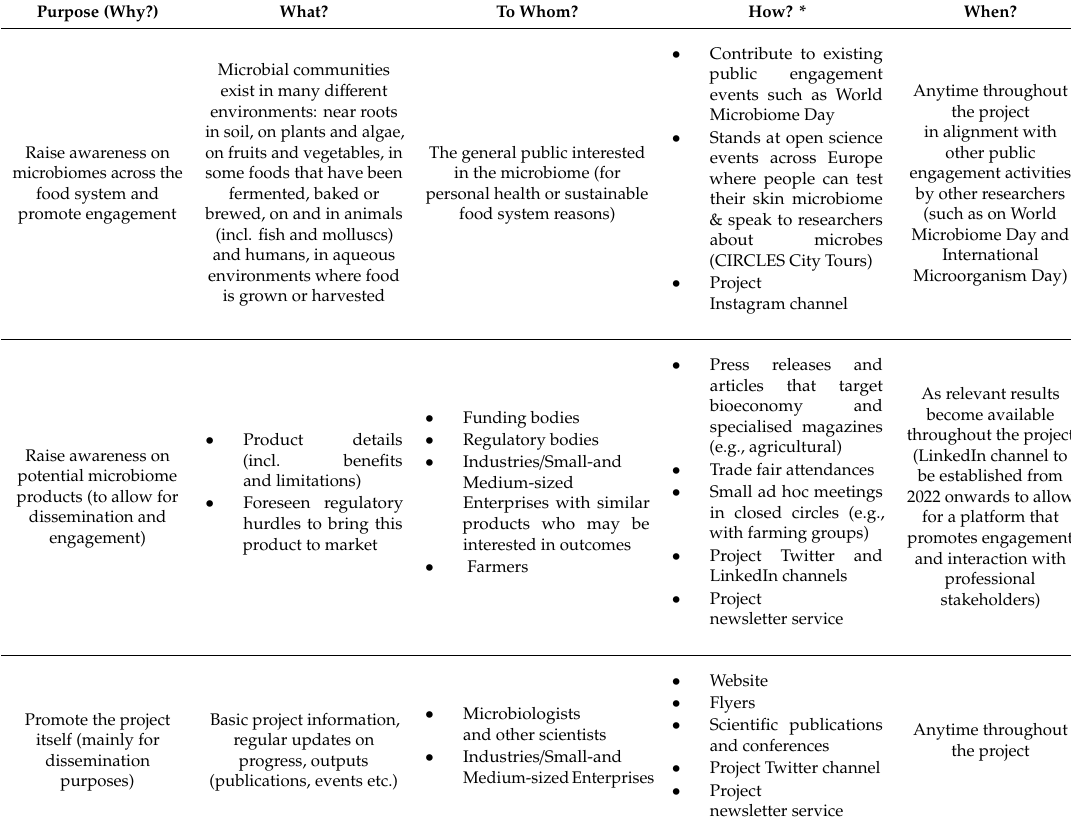
Table 1. Example of some of the CIRCLES (Controlling mIcRobiome CircuLations for bEtter food Systems) project’s main aims for communication and dissemination: How are key messages shaped? To whom are they targeted? How and when are they